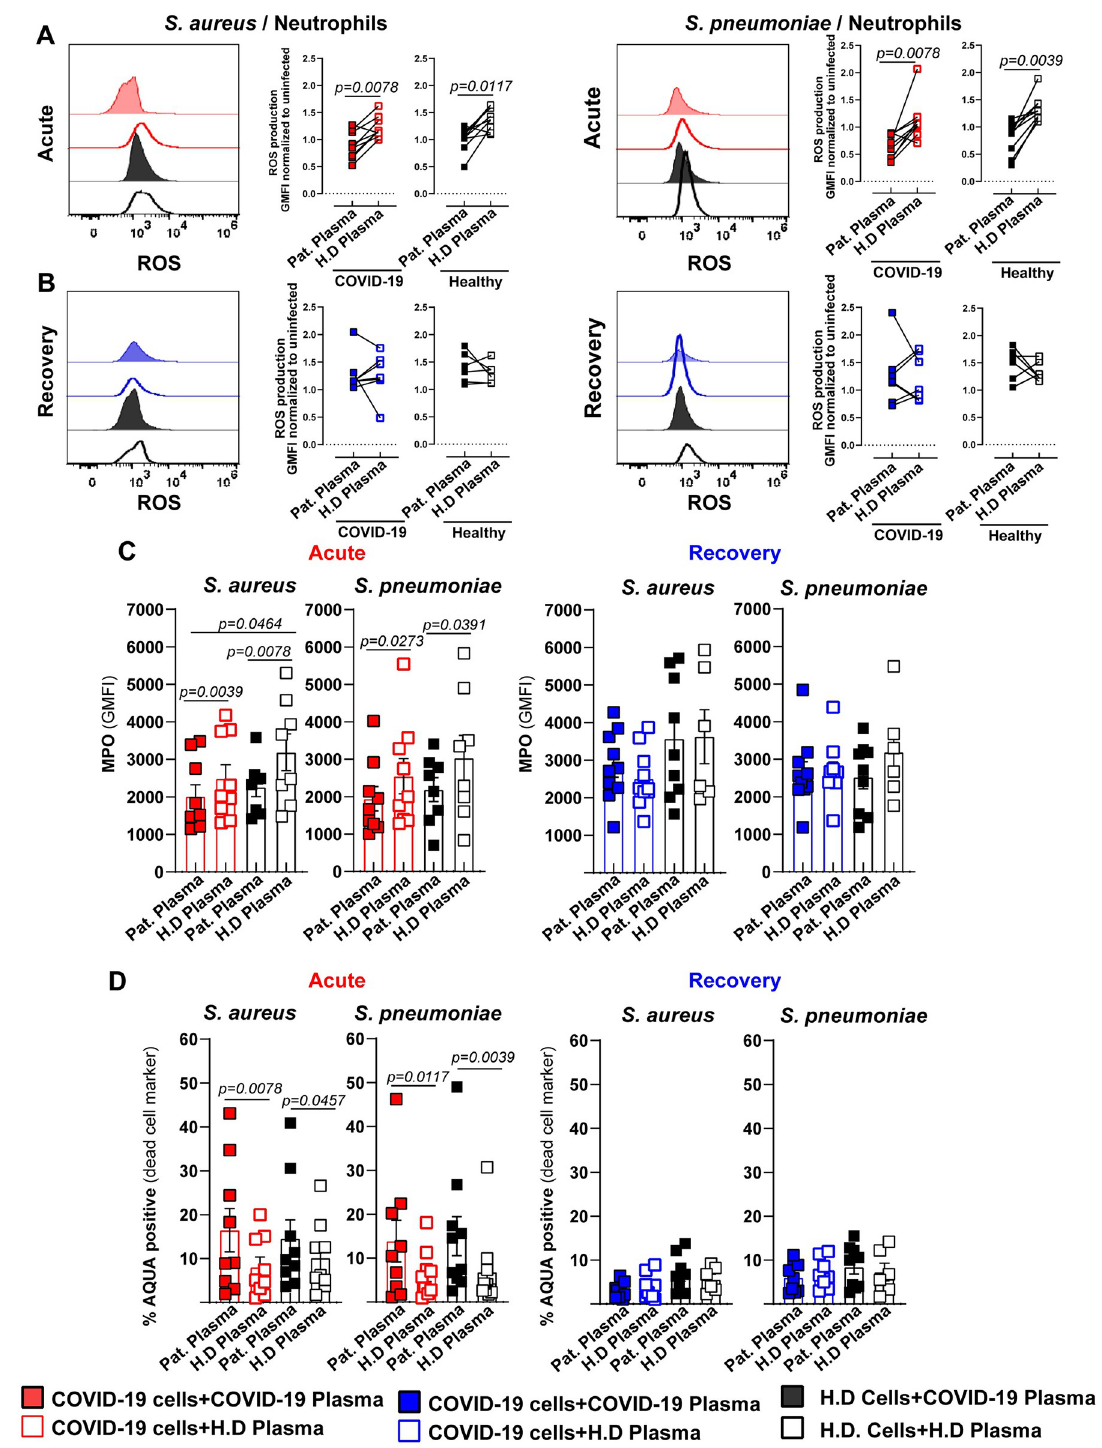
Fig 3. Impaired neutrophil effector response against bacterial challenge in acute COVID-19 patients. Functional characterization of COVID-19 patient’s (acute-phase: red and rec-phase: blue) or healthy donor’s neutrophils pre-exposed to 10% COVID-19 plasma (solid symbols) or healthy plasma (open symbols) for 3 h and subsequently challenged with either SA or SP at MOI 1. ( A and B ). Neutrophil functionality was assessed by quantification of ROS in acute- ( A ) and rec-phase patients ( B ) (n = 7–8), intracellular MPO ( C ) (right: acute-phase) (left: rec-phase) and cell viability ( D ) (right: acute-phase) (left: rec-phase) (n = 7–9) and compared to healthy donors. Each